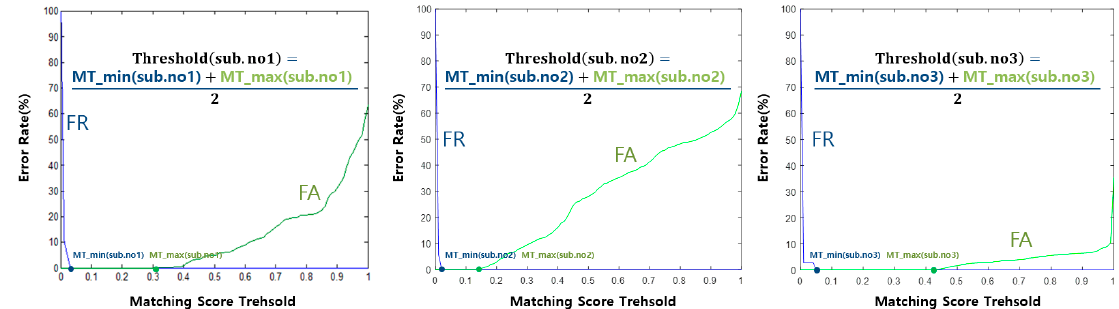
Figure 8. Examples of false rejection and acceptance rates for Subject no. 1, no. 2, and no. 3.